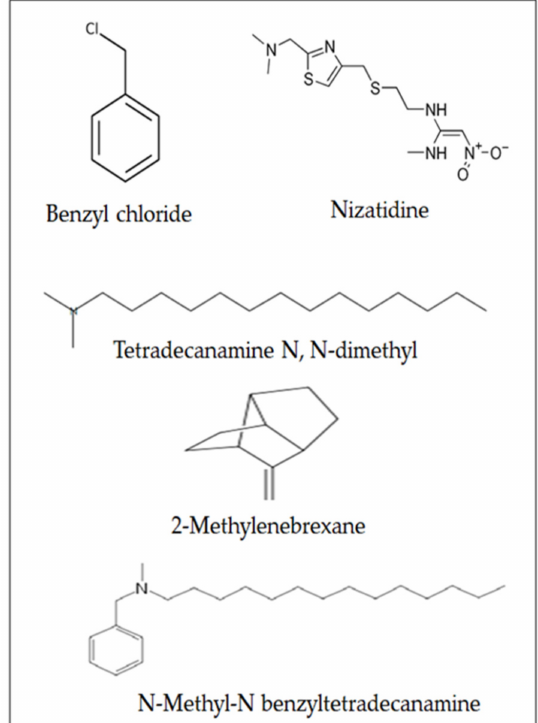
Figure 1. The most abundant phytochemical constituents of MLE.